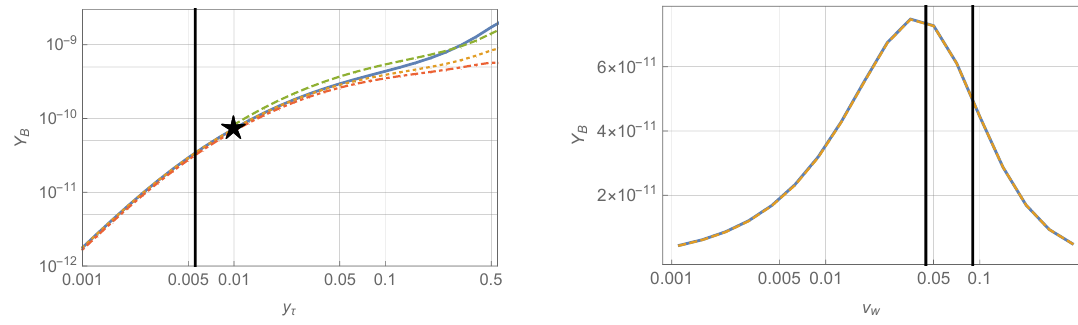
Figure 1 . Left: Y B as a function of the Yukawa coupling y (cid:28) for the same four approximations as in table 1 (solid blue: N( l; h; q; t ), dotted orange: N( l ), dashed green N( l; (cid:28) ), dotdashed red: A( l )). The region left (right) of the vertical black line corresponds to region a ( b ). The star denotes the SM value of y (cid:28) . Right: Y B as a function of the bubble-wall velocity v w (solid blue: N ( l; h; q; t ), dashed orange: N( l )). The left, middle and right regions correspond to regions c , b , and a , respectively. & 0 : 1, region b to 0 : 04 . v . 0 : 1, the SM tau Yukawa coupling, region a corresponds to v w w . 0 : and region c to v w